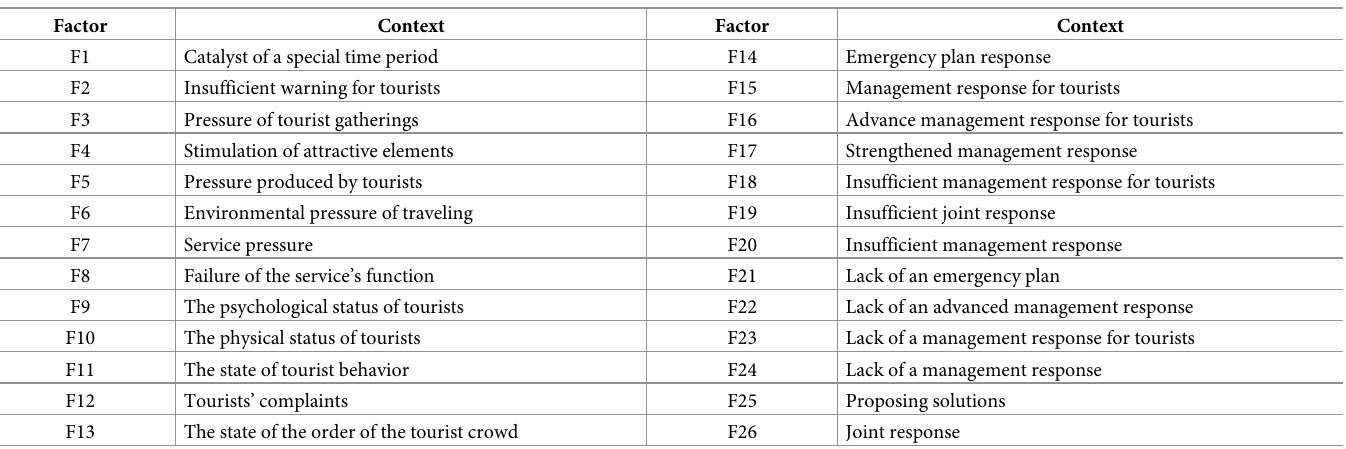
Table 1. The factors influencing the safety of